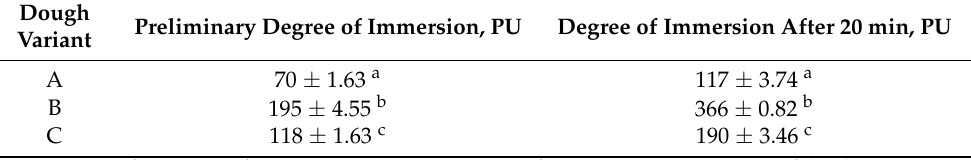
Table 5. Fermentation characteristics of nongluten dough formulations.